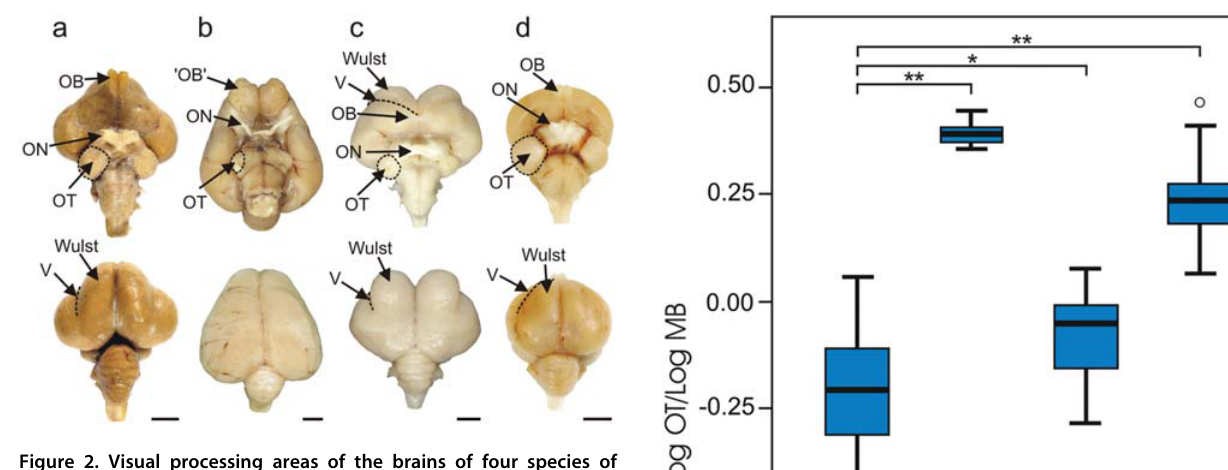
Figure 2. Visual processing areas of the brains of four species of birds. Ventral and dorsal views of the brains of a, Emu (diurnal, flightless); b , Kiwi (nocturnal, flightless); c, Barn Owl (nocturnal, flying), and d, Pigeon (diurnal, flying). OT: optic tectum; ON: optic nerve ; OB; olfactory bulb (which actually consists of a cortical-like sheet in the adult kiwi – see Fig. 6b); V: vallecula. Note the reduced diameter of the optic nerve in Kiwi compared with that in the three other species (see text for actual measurements). In the dorsal view of Kiwi, note the